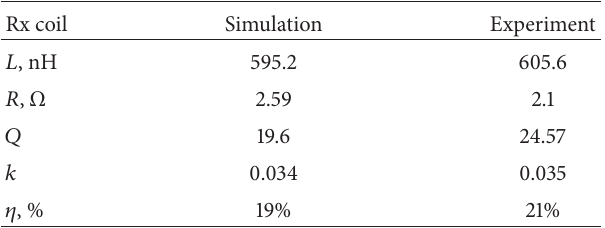
Table 2: Rx coil parameters and power transfer